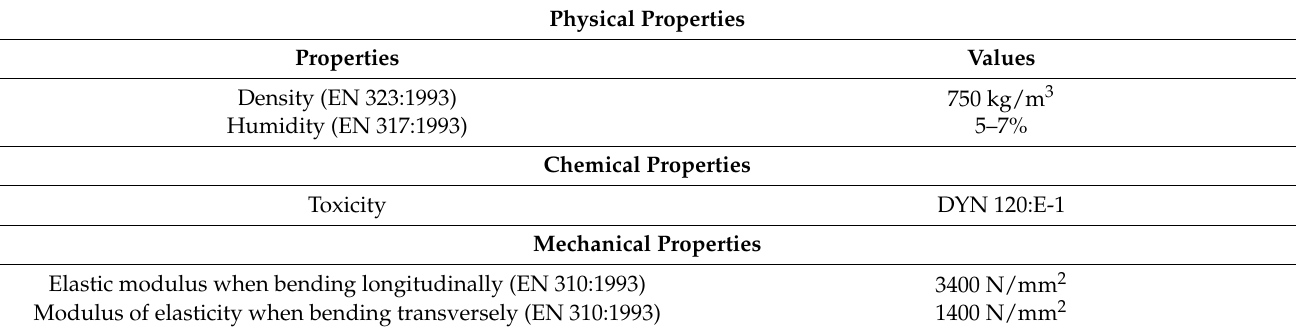
Table 4. The physical, chemical and mechanical properties of the LPB as provided by the manufacturer.